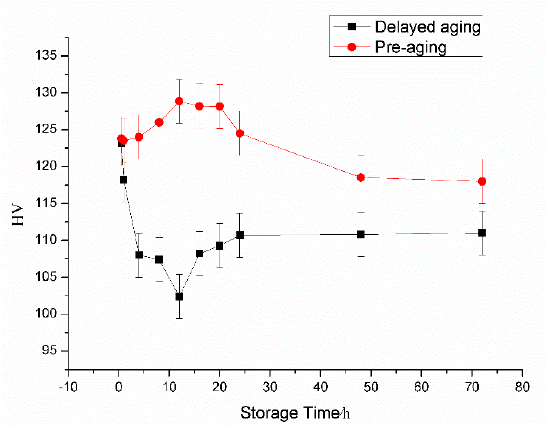
Figure 7. Hardness curve of the alloys treated with two different aging.